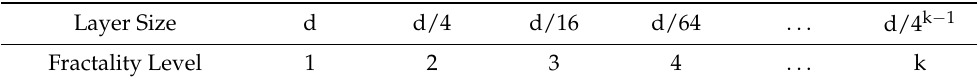
Table 2. Dependence of the layer size on the level of fractality.